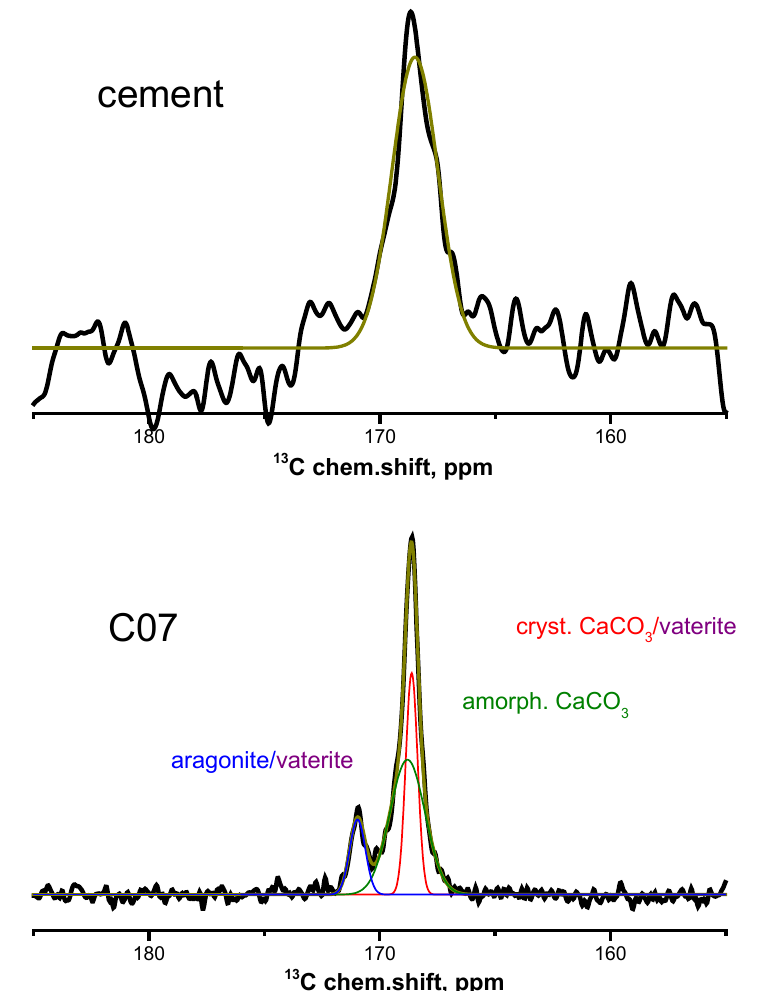
Figure 1. 13 C NMR spectra of the ( top ) anhydrated Portland-limestone cement, and ( bottom ) cement paste sample without additives on the 7th day of hydration.